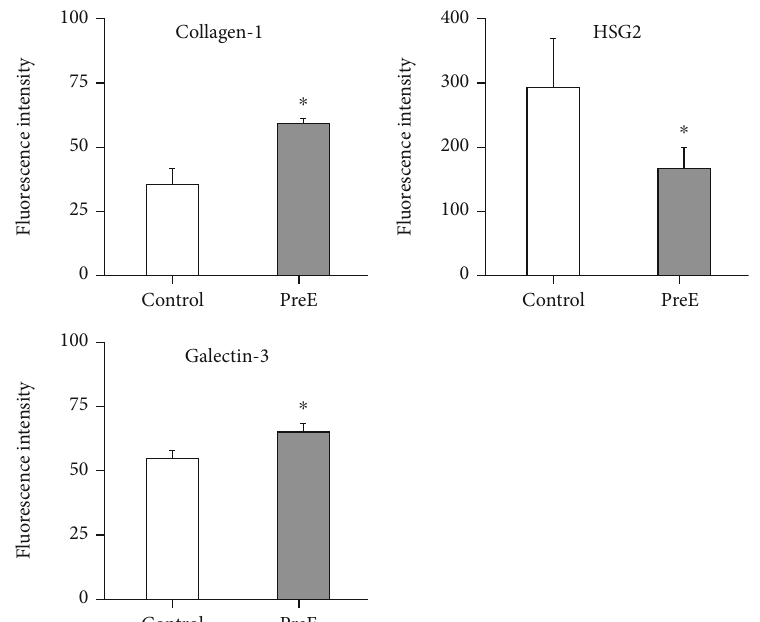
Figure 2: Critical components of the pECM were analyzed to establish changes in their expression. Collagen-1 expression is signi fi cantly increased, heparan-sulfate proteoglycan 2 is signi fi cantly decreased, and galectin-3 is signi fi cantly increased in